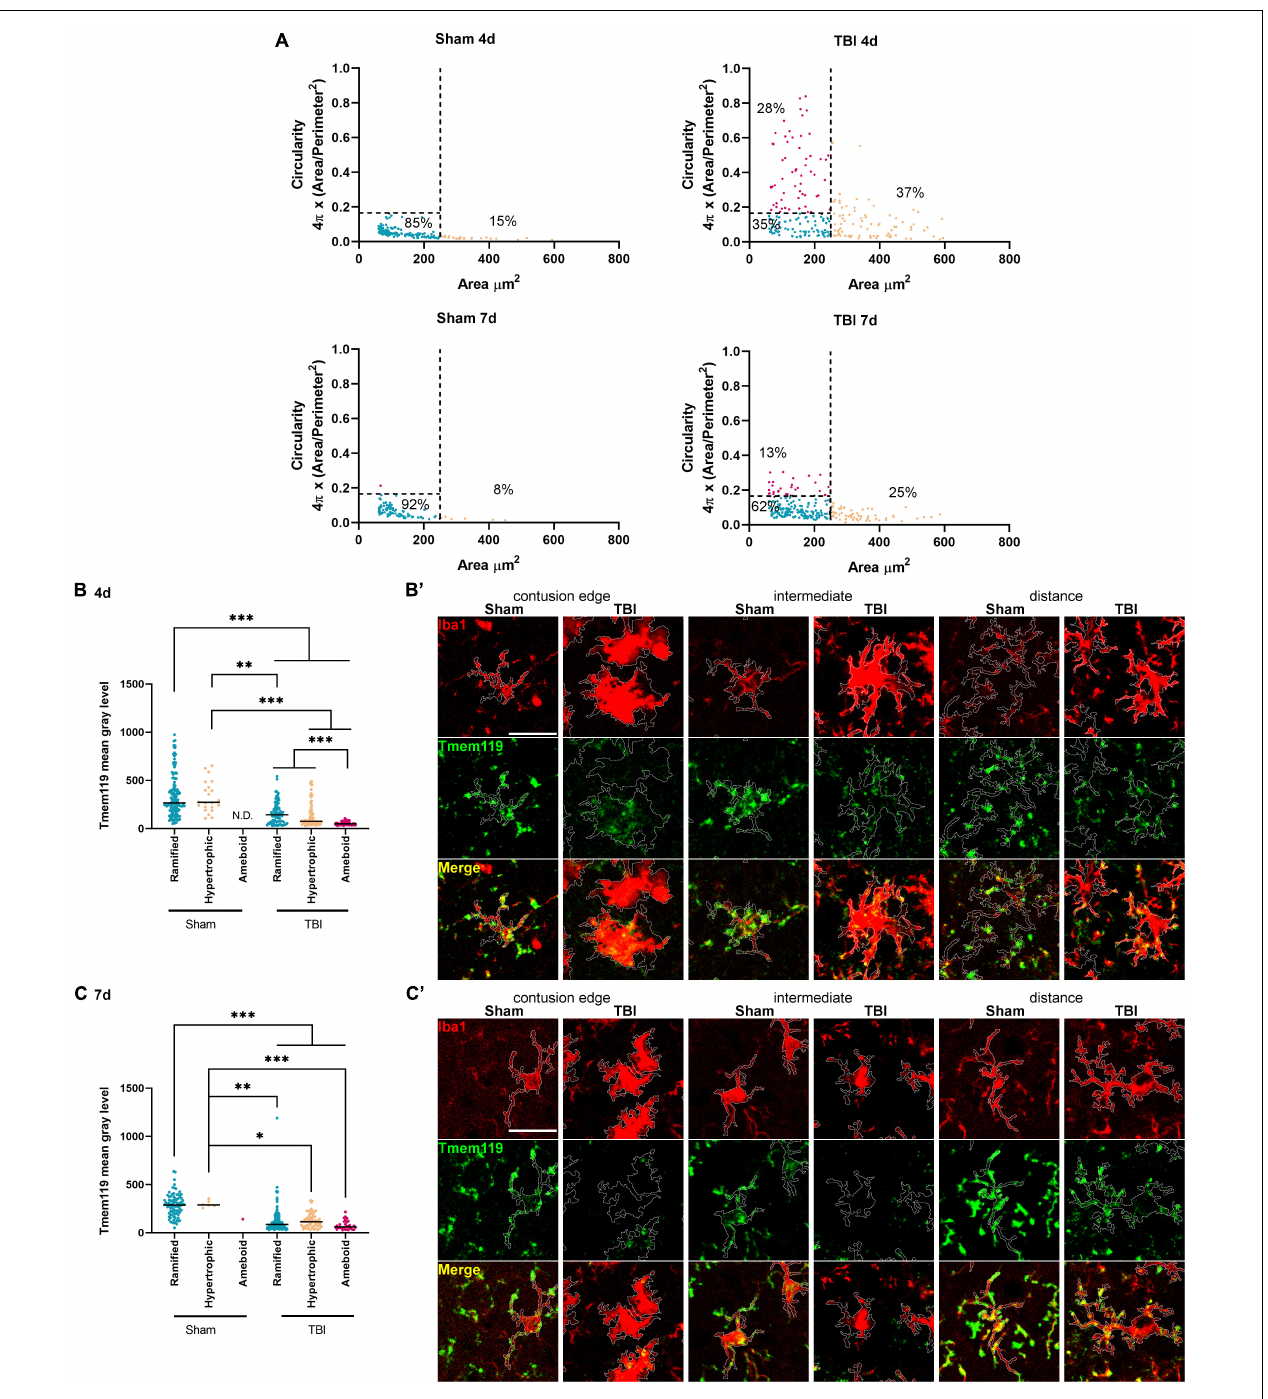
FIGURE 4 | Stratification of Iba1 + cells based on their morphology and Tmem119 immunoreactivity after Iba1+ morphological stratification. (A) Distribution of Iba1+ cells based on area and circularity. We gated the cells based on the area (cut-off at 250 µ m 2 ) and circularity (cut-offs at 0.16). Cut-offs are indicated by the dotted lines. The relative proportions of Iba1+ in each gated population are indicated in the graph. (B,B’) The Tmem119 levels of each gated Iba1+ cell populations decreased significantly at 4 days after TBI compared to sham, with ameboid and cells having the lowest Tmem119 values of immunoreactivity (B) . Representative micro photograms showing Iba1 + (red) and Tmem119 + (green) cells in the three regions of interest. The Tmem119 immunoreactivity was calculated within the Iba1+ outline (white) traced using an originally developed ImageJ algorithm ( B’ , scale bar 20 µ m). (C,C’) The Tmem119 immunoreactivity of each gated Iba1+ cell populations decreased significantly at 7 days after TBI compared to sham (C) . Representative micro photograms showing Iba1 + (red) and Tmem119 + (green) cells ( C’ , scale bar 20 µ m). Data are shown as scatter dot plot, a line at mean, and n = 92–155 cells from three mice per group. Kruskal–Wallis test followed by Dunn’s multiple comparisons tests, ∗∗∗ p < 0.001, ∗∗ p < 0.01, and ∗ p < 0.05.